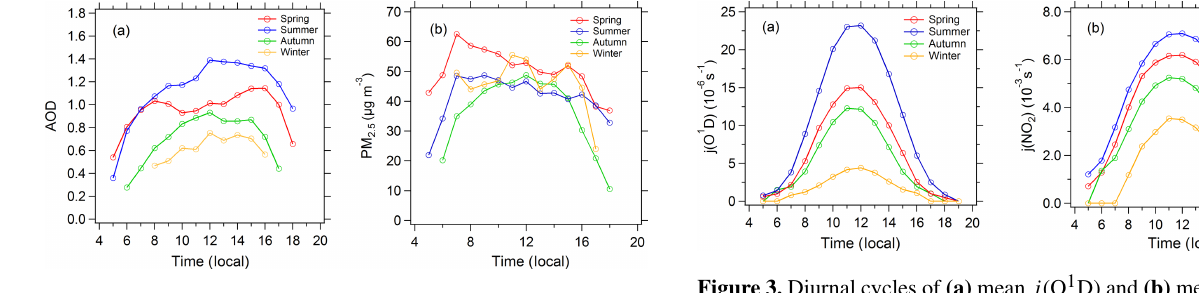
Figure 2. Diurnal cycles of (a) mean AOD and (b) mean PM 2 . 5 in the four seasons under cloudless conditions.